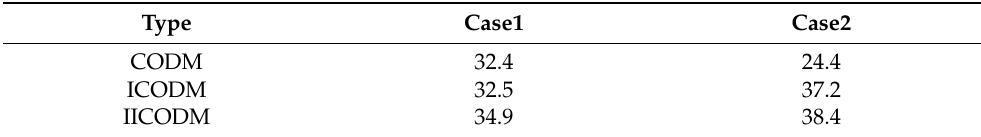
Table 7. The computation time of three methods in two cases